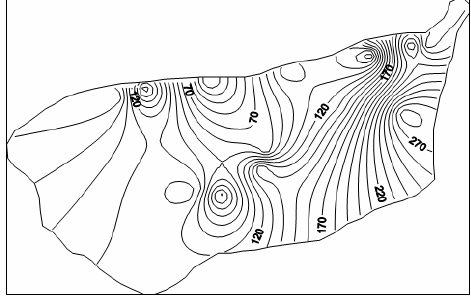
Figure 8. Seasonal variations of HCO